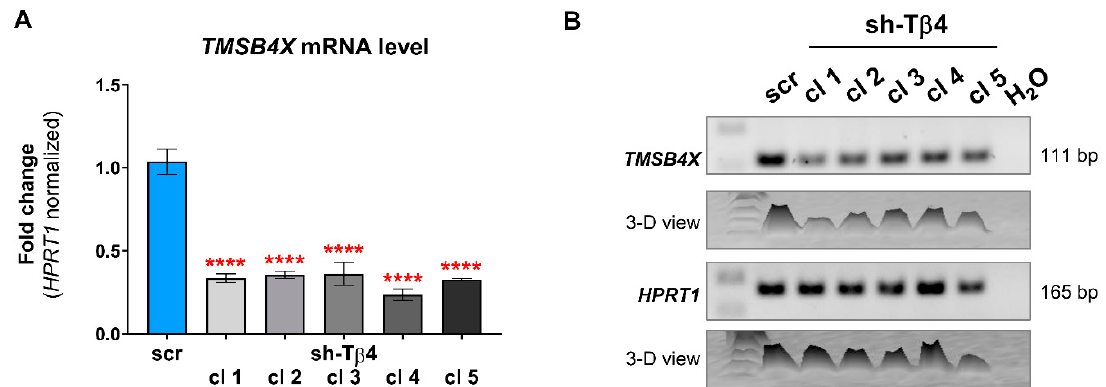
Figure 1. Estimation of efficiency of silencing of TMSB4X expression in A375 cells. Stable clones with lowered TMSB4X expression were obtained using shRNA constructs. ( A ) qPCR analysis of TMSB4X expression level. As templates, cDNAs of the A375 scr and sh-T β 4 clones served. The results were normalized against the HPRT1 gene and scr cells ( n = 3). The significance level was set at **** p < 0.0001. The graph indicates means ± SD. ( B ) RT-PCR analysis of TMSB4X expression level. 2% Tris-acetate-EDTA (TAE)-agarose gel was used to separate DNA fragments.